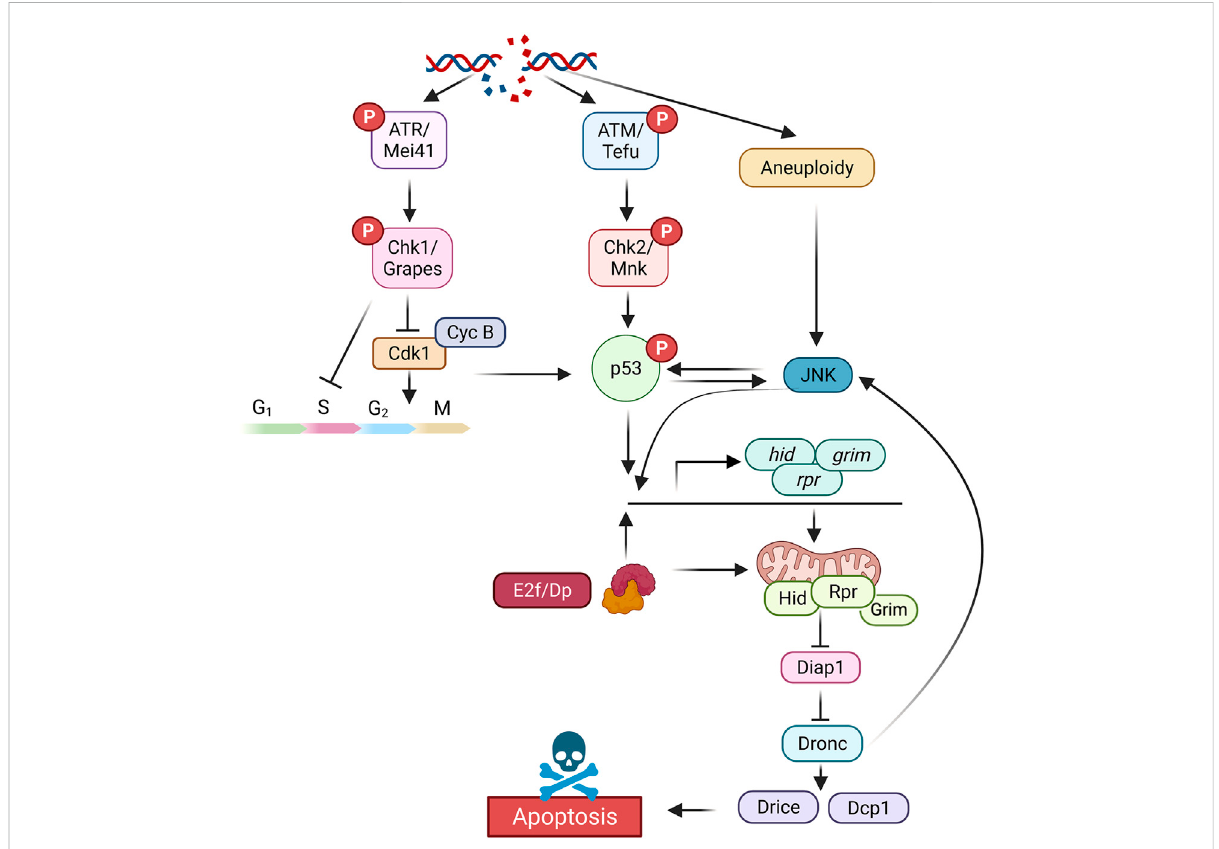
FIGURE 1 Simpli fi ed representation of the different components of the DNA damage response pathway that leads to cell cycle arrest and apoptotic induction in Drosophila . Created with